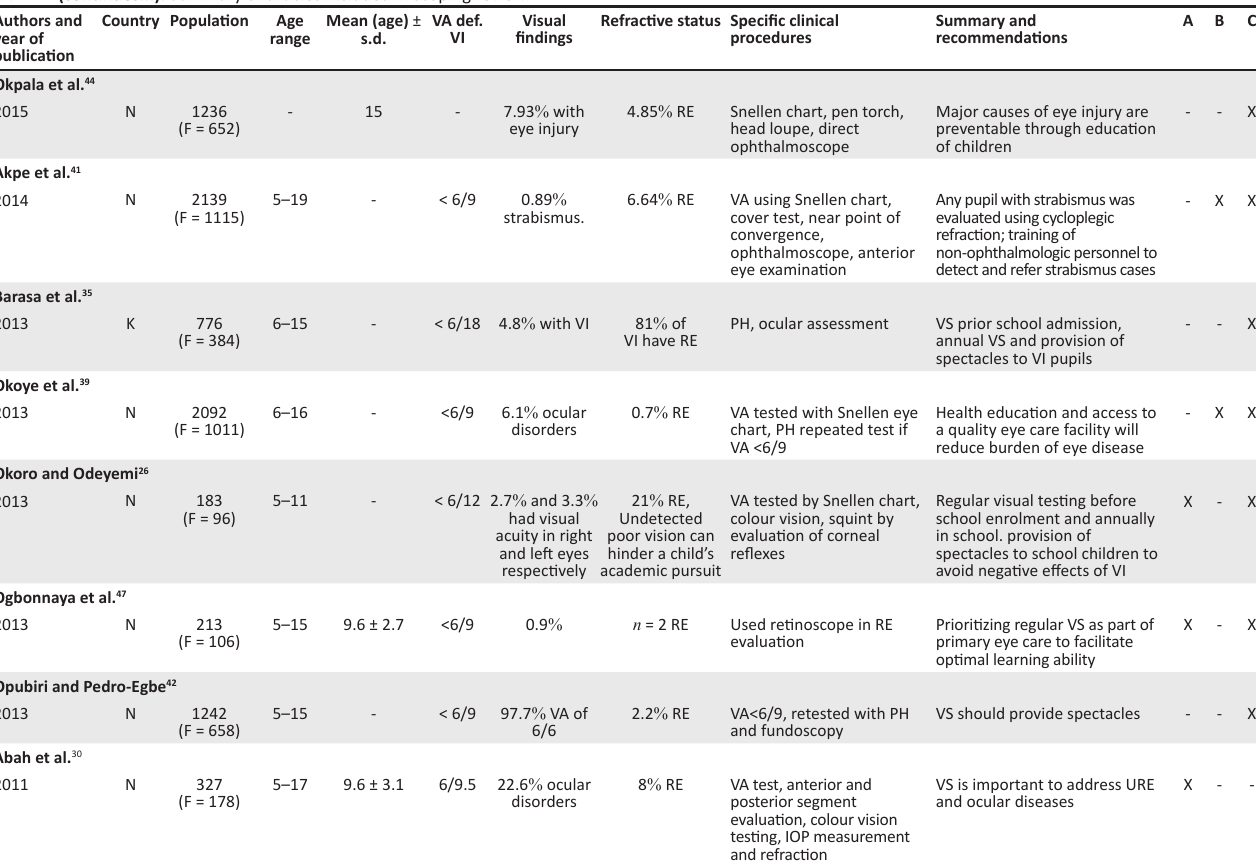
TABLE 1 (continues...): Summary of articles included in scoping review.